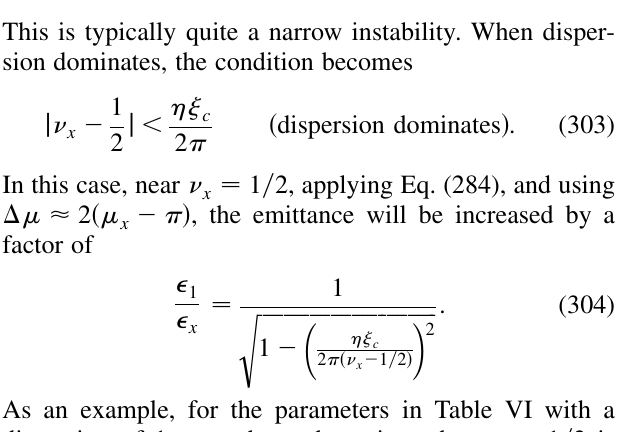
and (cid:2) (cid:8) defined in Eqs. (287) and (288). The lower x; pr z; pr and (cid:2) (cid:1) defined in Eqs. (290) and x; pr z; pr